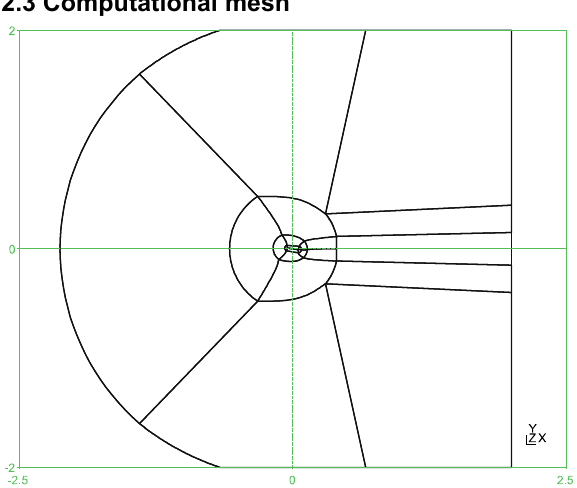
Fig. 1 . The blocking structure of the mesh axes ticks in metres while the plate has chord of 0.1